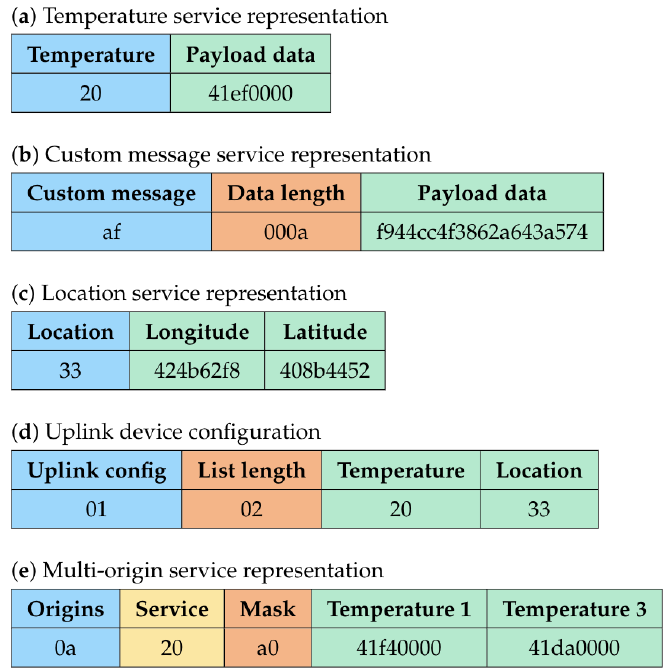
Figure 2. Service message formats examples.